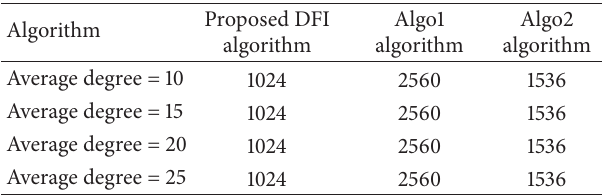
Table 5: Total number of message exchanged for different algo-